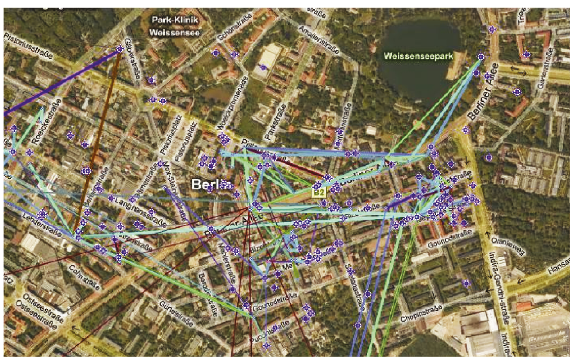
Figure 6: Map of Berlin Freifunk network.